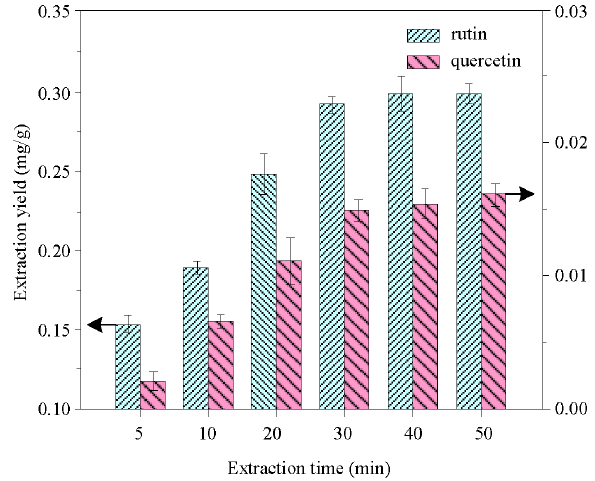
Figure 5. Effect of extraction time using 60% concentration of ethanol solution with 40 mL/g of ratio and 80 kHz at 30 °C and 200 W on the extraction of quercetin and rutin.